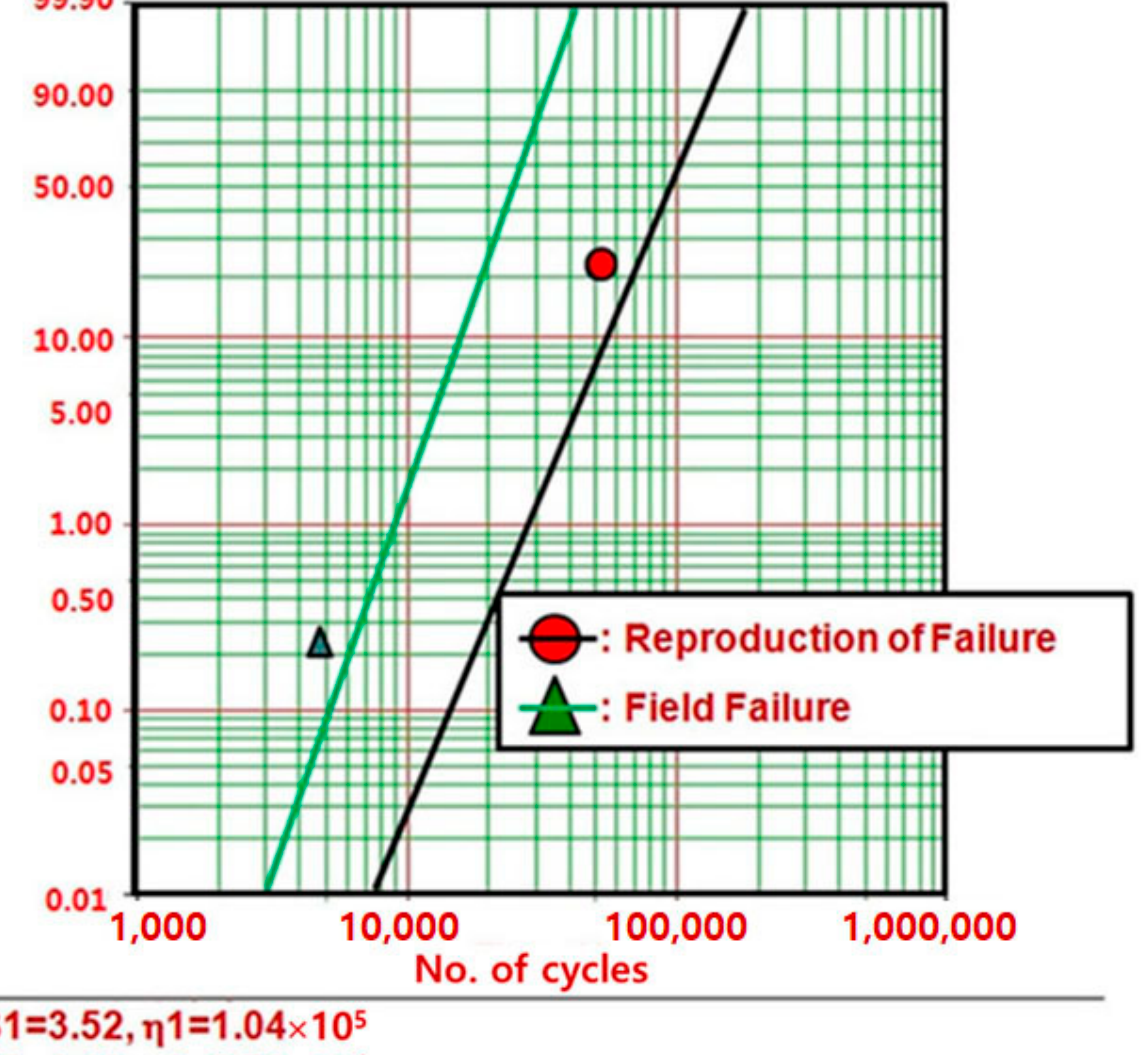
Figure 12. Outcomes of fail reproduction and market failure on the Weibull plot.